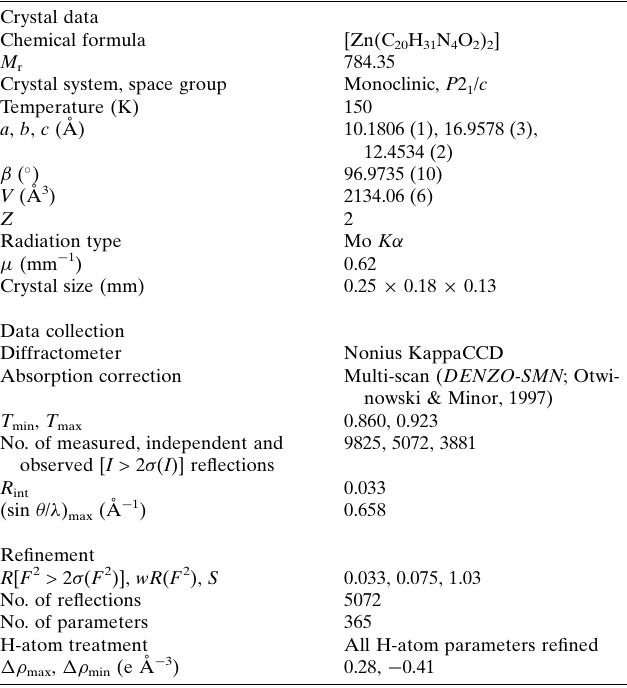
Table 3 Experimental details. Crystal data Chemical